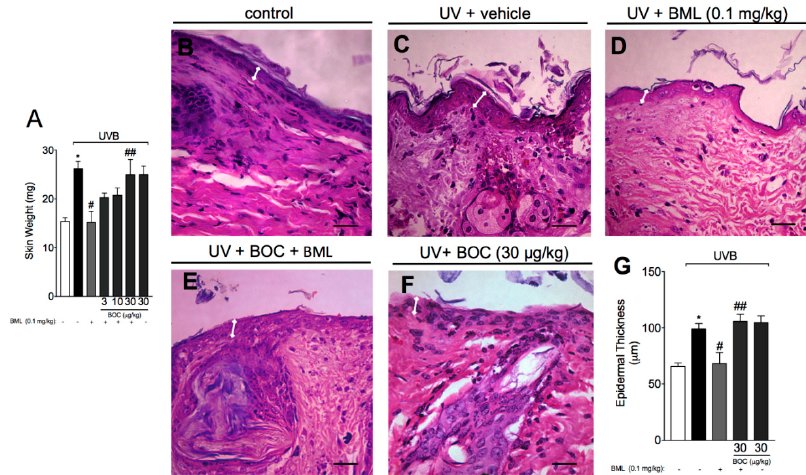
Figure 2. BML-111 reduces skin edema and the increase in epidermal thickness induced by UVB radiation. The skin edema ( A ) were determined in samples dissected 12 h after the radiation. The epidermal thickness was determined in samples dissected 12 h after the radiation and stained with hematoxylin and eosin (H&E). Representative images of non-irradiated control ( B ), irradiated treated with vehicle ( C ), irradiated treated with 0.1 mg/kg of BML-111 ( D ), irradiated treated with BOC and BML-111 ( E ), and irradiated treated with BOC ( F ) groups are presented. Epidermal thickness of experimental groups is presented in µ m ( G ). Original magnification 40 × ; 100 µ m. Results are expressed as mean ± SEM and are representative of two independent experiments. One-way ANOVA followed by Tukey’s post-test * p < 0.05 compared to non-irradiated group, # p < 0.05 compared to irradiated vehicle-treated group, ## p < 0.05 compared to BML-111 group.